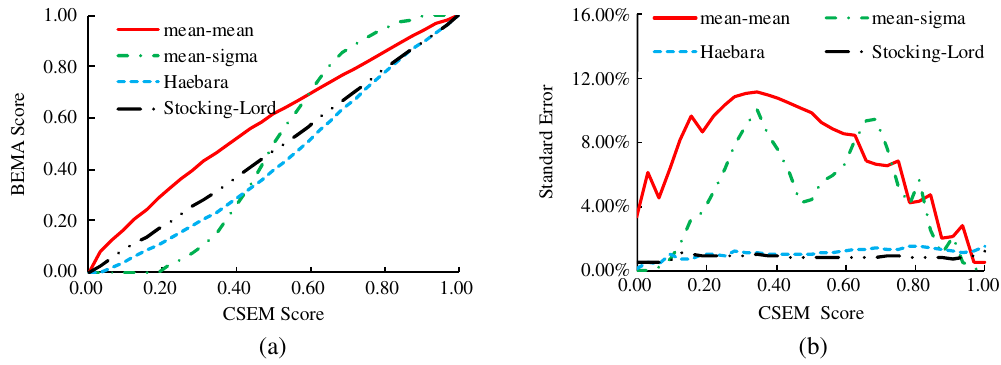
FIG. 5. Results for linking the BEMA and CSEM. (a) Linking function between BEMA and CSEM, and (b) the conditional SE for linking BEMA and CSEM.